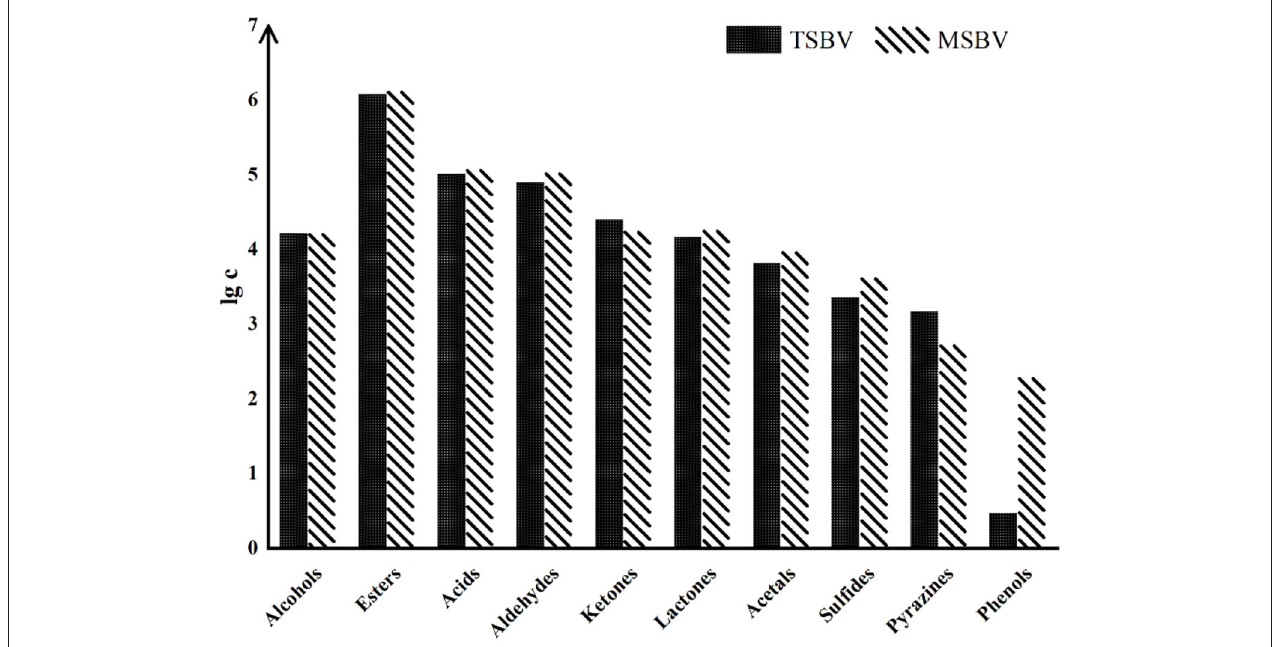
FIGURE 6 | The logarithm of total concentration ( µ g/L) of the aroma-active chemical groups in both TSBV and MSBV samples (Cited and modified from Al-Dalai et al., 2020a).